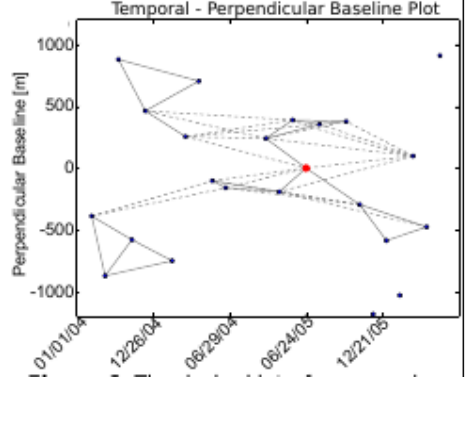
Figure 3 : Interferograms and coherence values. The perpendicular baselines increase from left to right. Top labels provide the master and slave dates.